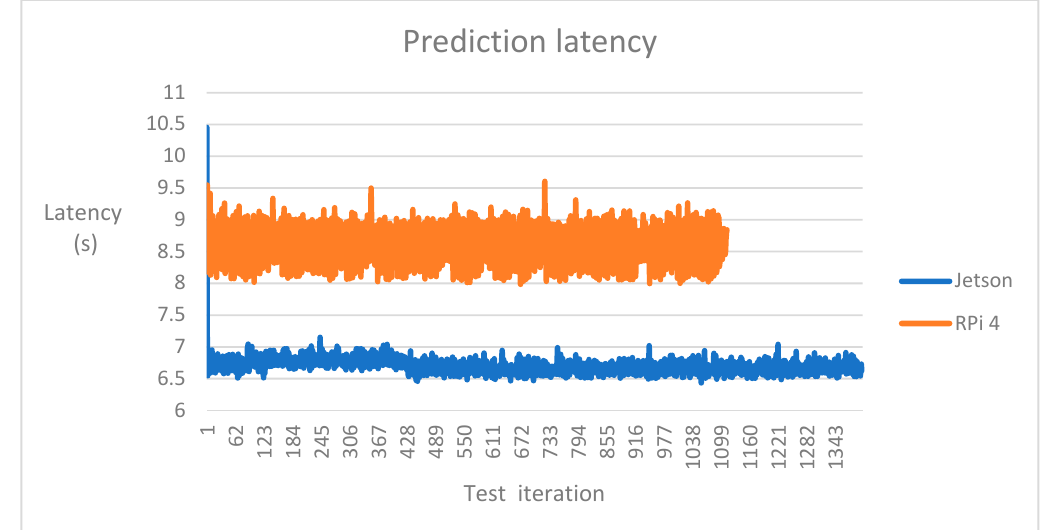
Figure 8. Results of prediction tests.